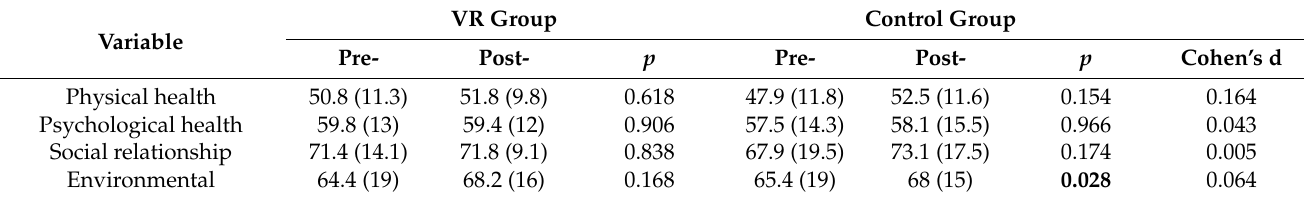
Table 3. Analysis of the quality of life.